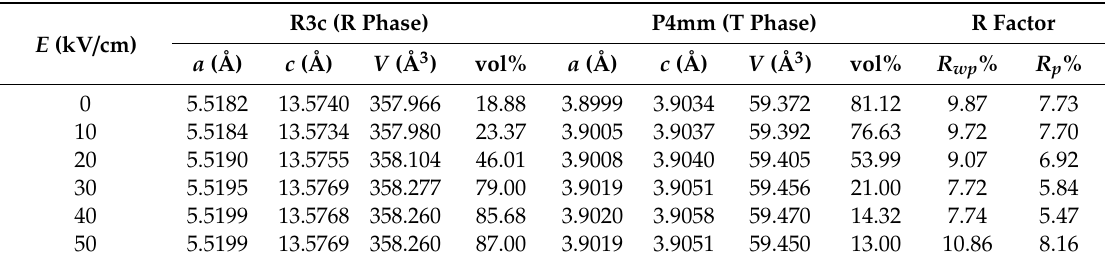
Figure 4. XRD Rietveld analyses of NKBET20 ceramics poled under various electric fields. ( A ) 0 kV/cm, ( B ) 10 kV/cm, ( C ) 20 kV/cm, ( D ) 30 kV/cm, ( E ) 40 kV/cm, ( F ) 50 kV/cm. Adapted from our earlier work [27]. Table 1. The refinement parameters of XRD Rietveld analyses.